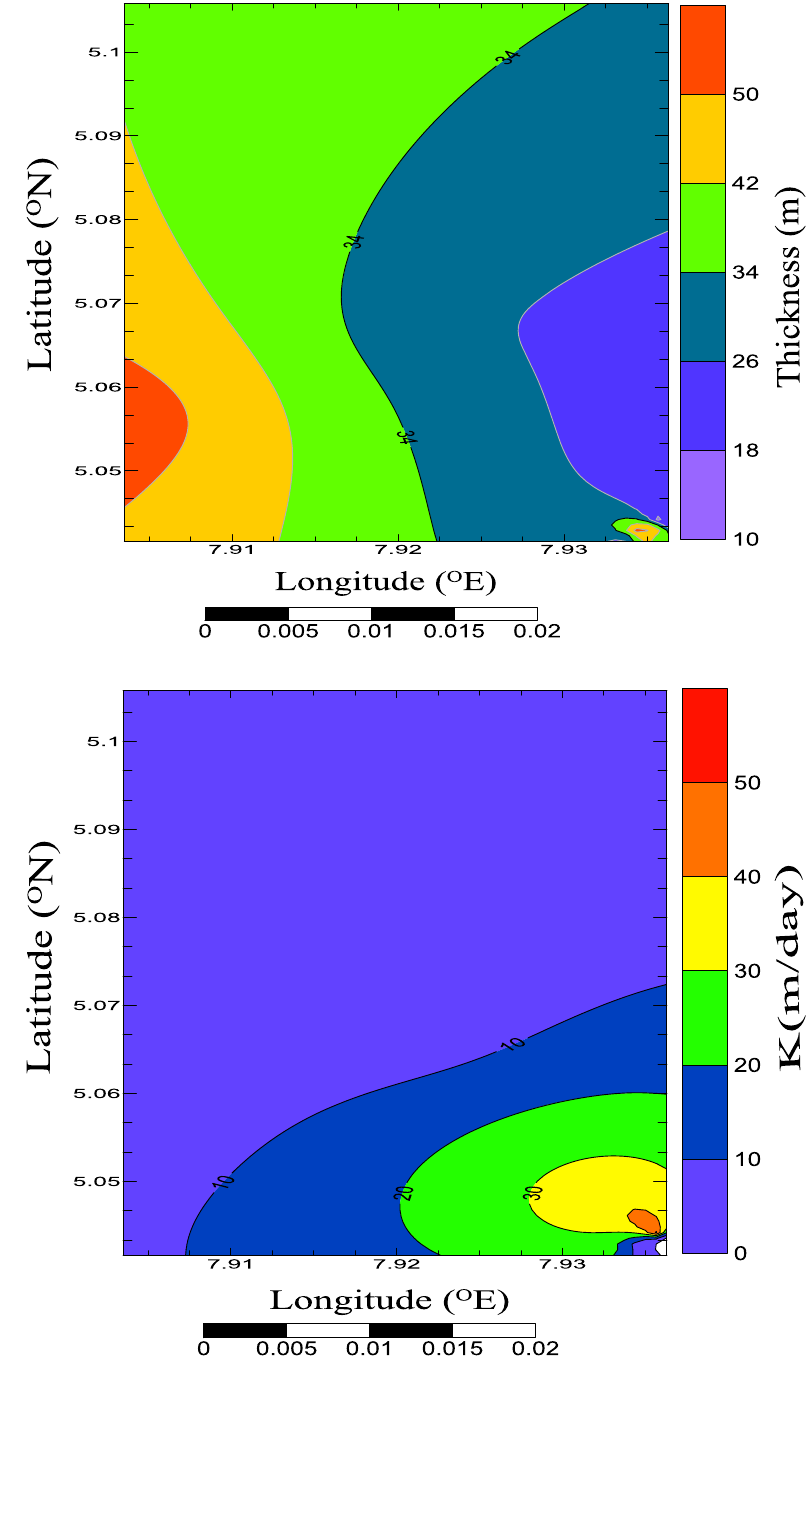
Fig. 4 Contour map showing the variation of thickness